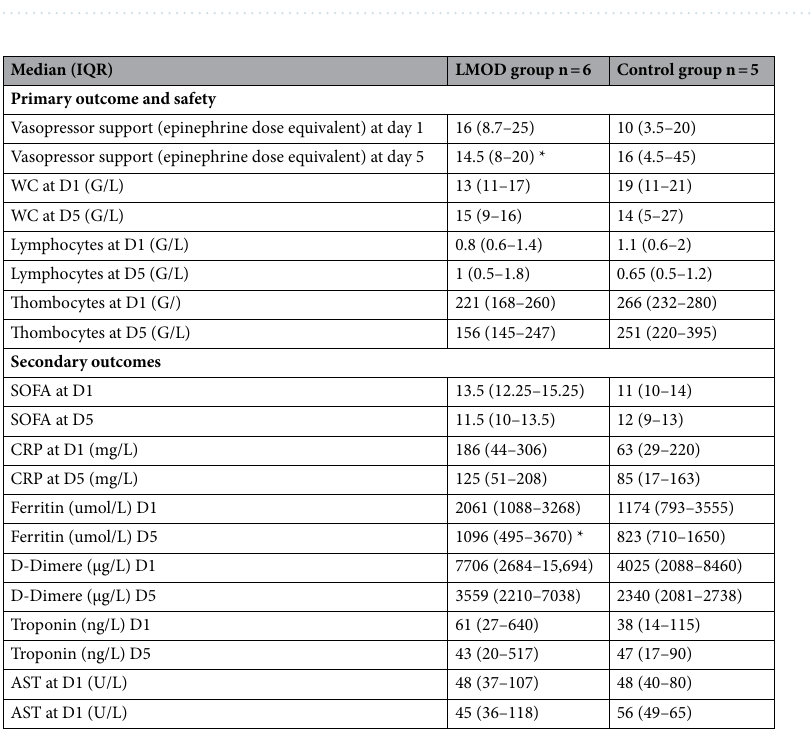
Figure 1. Safety of LMOD treatment. ( A ) median of the mean arterial pressure all the LMOD treatment along. ( B ) Whites cells changes in LMOD group compared to control group. L-MOD patients are in red and control patients in blue. MAP = Mean arterial blood pressure.